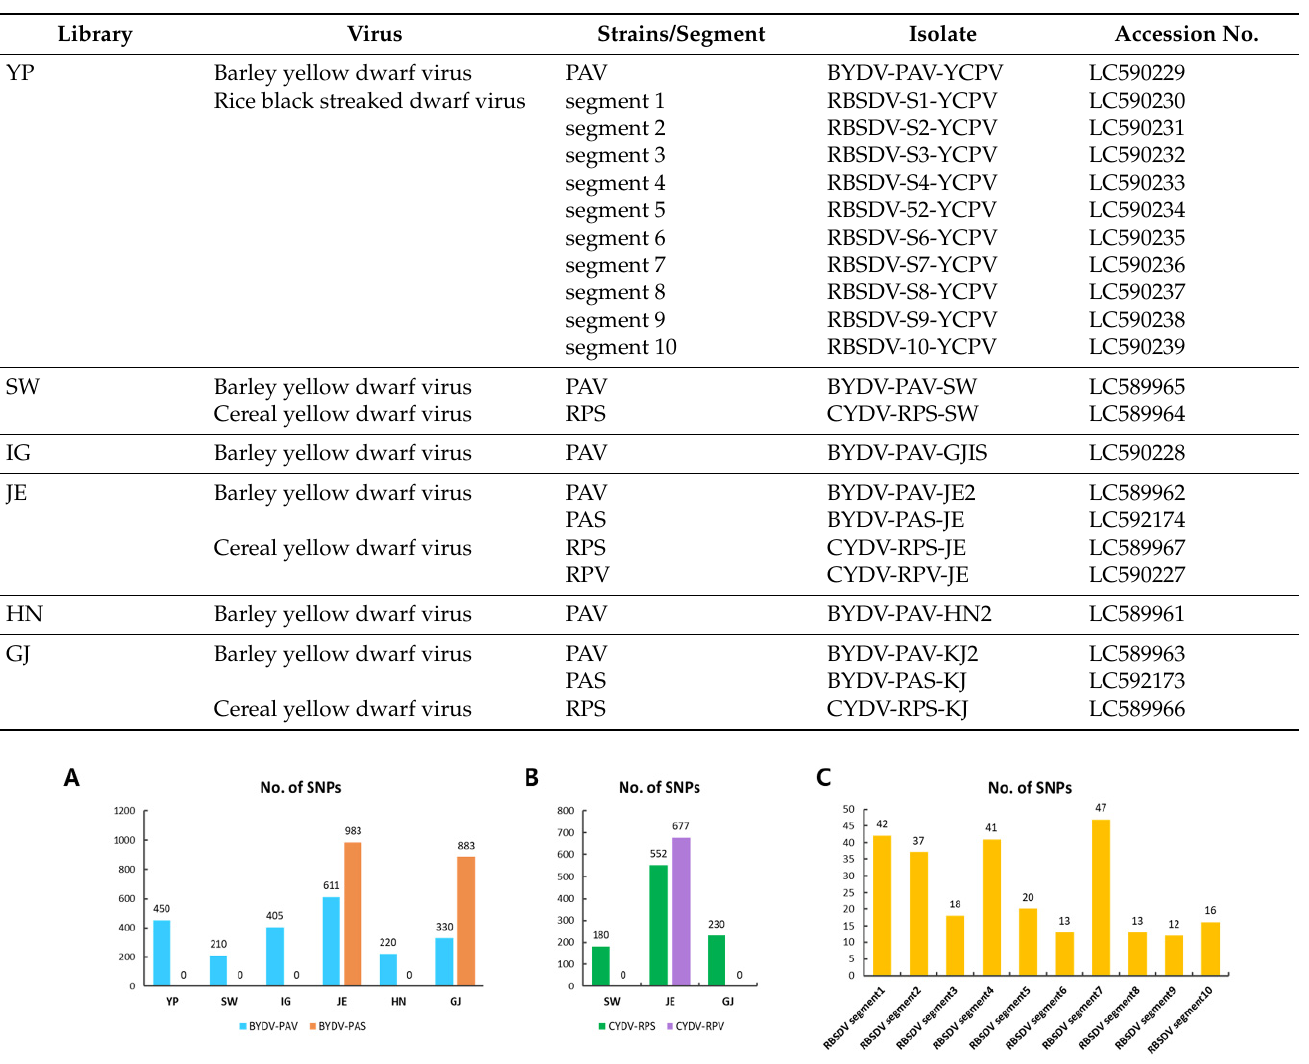
Figure 6. Identification of SNPs for identified viruses in each library. ( A ) The number of identified SNPs for BYDV-PAV and BYDV-PAS. ( B ) The number of identified SNPs for CYDV-RPS and CYDV-RPV. ( C ) The number of identified SNPs for RBSDV segments.